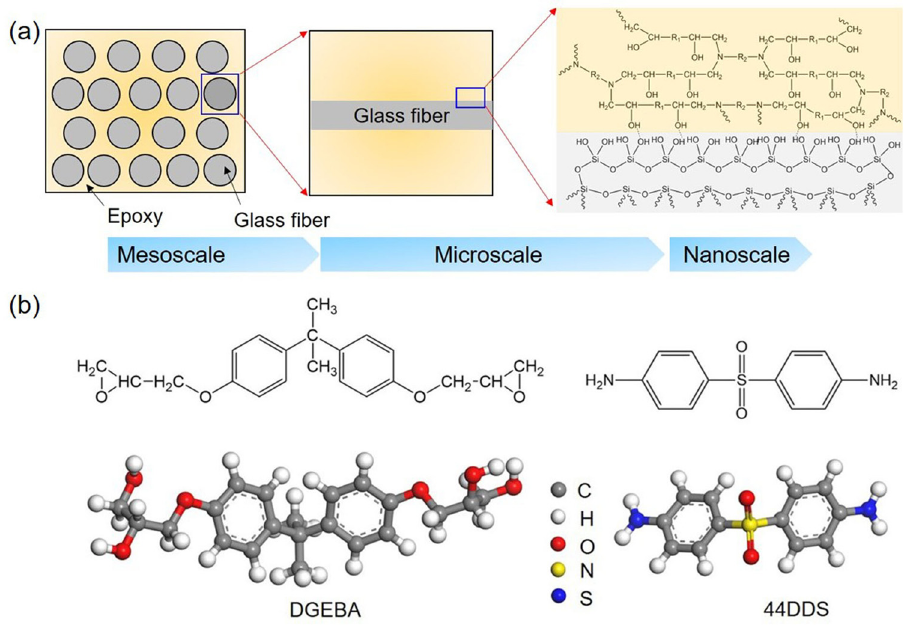
Figure 1: ( a ) Multiscale structures of glass fi ber - reinforced epoxy composites. ( b ) Molecular structures of DGEBA and 44DDS monomers of cross - linked